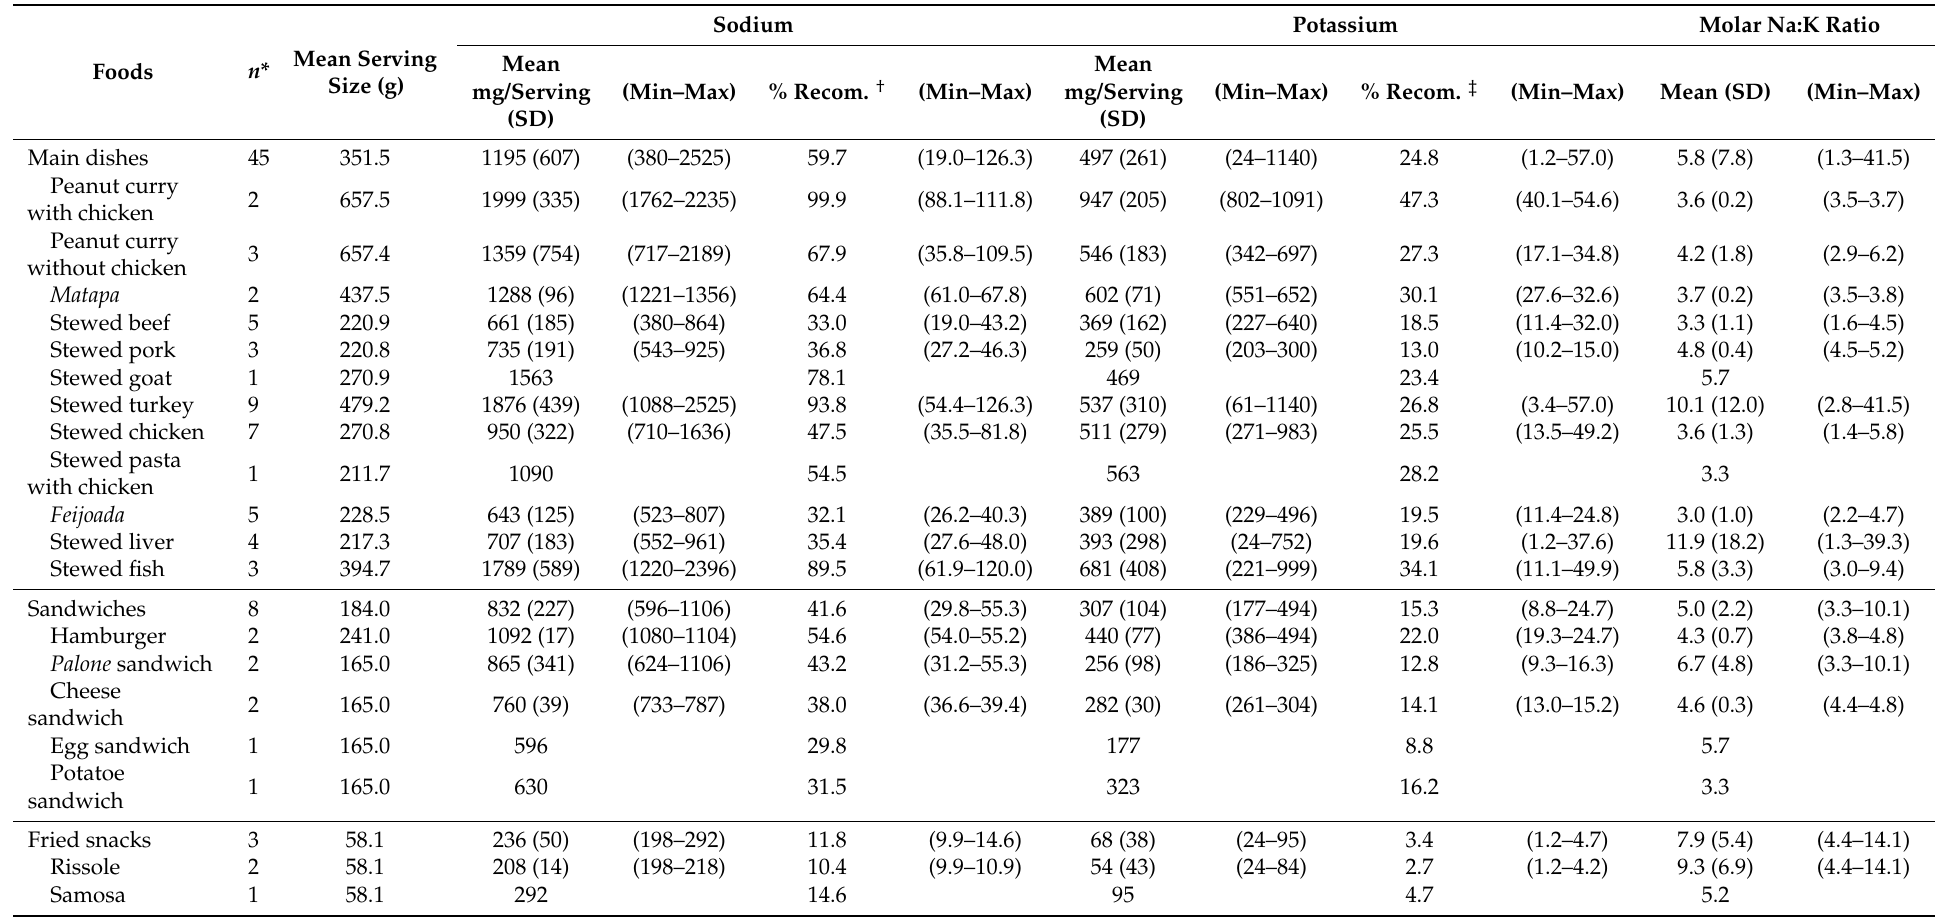
Table 1. Mean contents of sodium and potassium and sodium to potassium molar ratio of the collected homemade foods ( n = 56), within each food